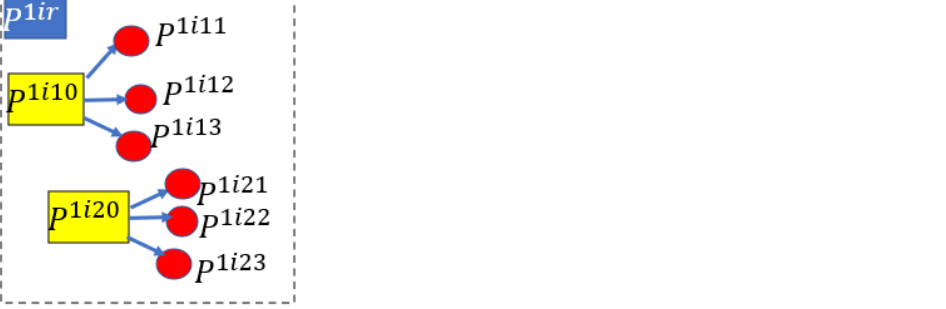
Figure 3. Problem structure for a single-period stochastic economic dispatch with multiple base case scenarios.